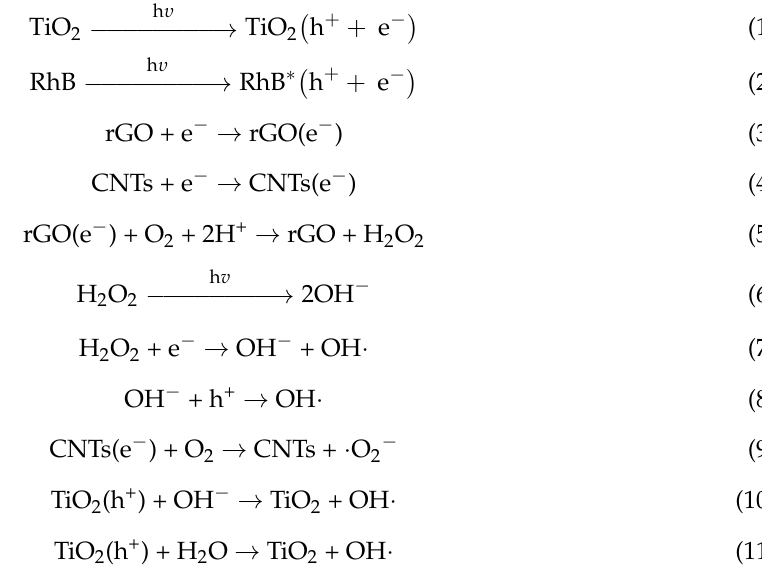
Figure S1: The SEM images of GO, oxide-treated CNTs, CNTs/GO, TiO 2 /CNTs/rGO-3%. Figure S2: The XRD patterns of rGO and GO. Figure S3: (a) The XRD patterns of TiO 2 /CNTs/rGO- x % ( x = 0.5, 1, 2, 3, 5, 10); (b) The Raman spectra of TiO 2 /CNTs/rGO- x % ( x = 0.5, 1, 2, 3, 5, 10). Figure S4: Plot of C / C 0 vs irradiation time of RhB degradation for TiO 2 /CNTs/rGO- x % ( x = 0.5, 1, 2, 3, 5, 10). Figure S5: The color change of RhB solution from 0, 10, 20, 30, 40, 50, 60 min under UV-vis light (from left to